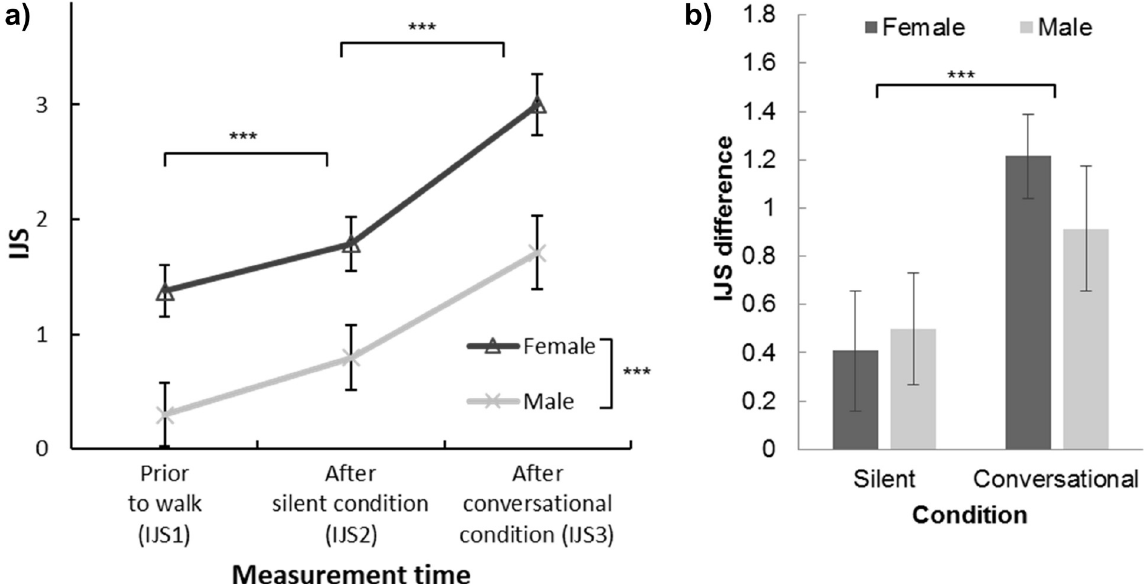
Fig 4. Results of impression rating for each gender. a) Means and 95% confidence intervals for female and male walkers’ total IJS scores measured before the silent condition (IJS1), after the silent condition (IJS2) and after the conversational condition (IJS3). b) IJS difference of each gender under silent (IJS2-IJS1) and conversational conditions (IJS3-IJS2) ( ��� , p <